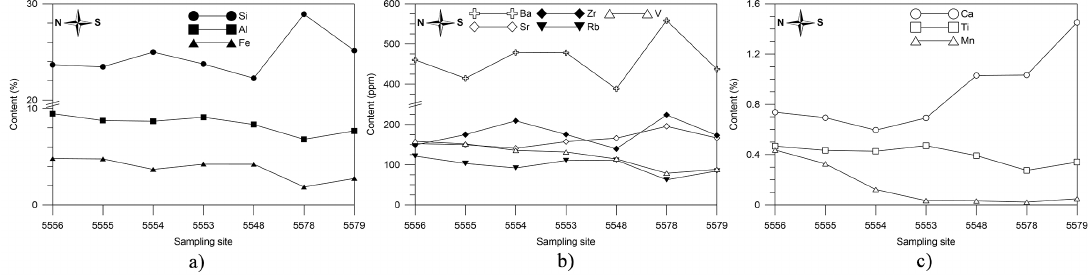
Figure 8. Variation of element concentrations in surface sediments at the Kola Transect along 32.400 ◦ E, the Barents Sea. Elements: ( a ) Si, Al, Fe; ( b ) Ba, Zr, Sr, Rb; ( c ) Ca, Ti,